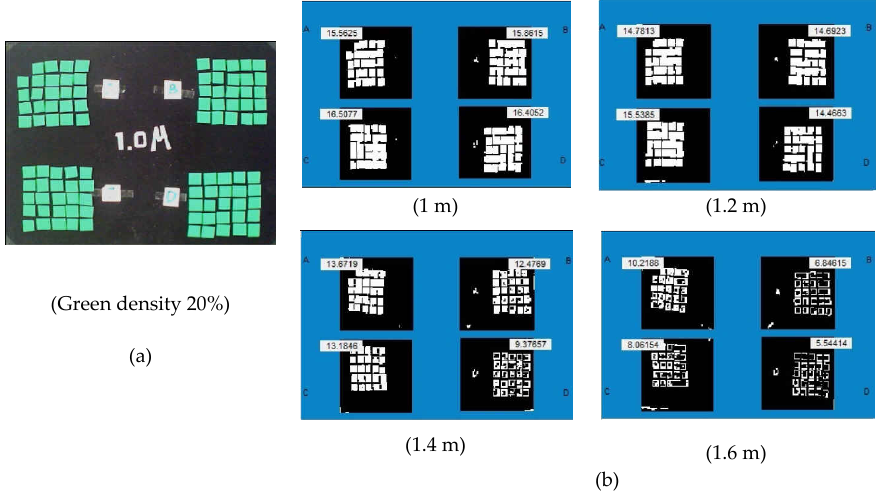
Figure 7. ( a ) Image processing calibration from wireless WebCAMs; ( b ) green color density 20% image segmented at different heights. Table 2. The effect of wireless WebCAMs altitude on the accuracy of image data acquisition with different colors and densities.